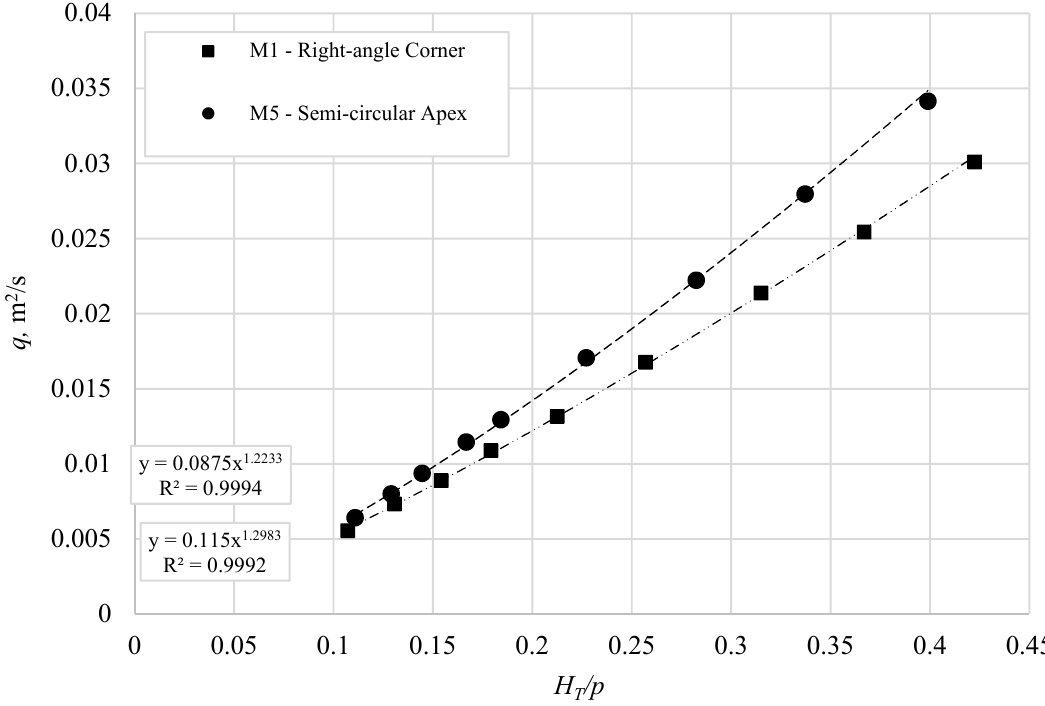
Figure 6. Comparison of discharge performance for M1 and M5 models.